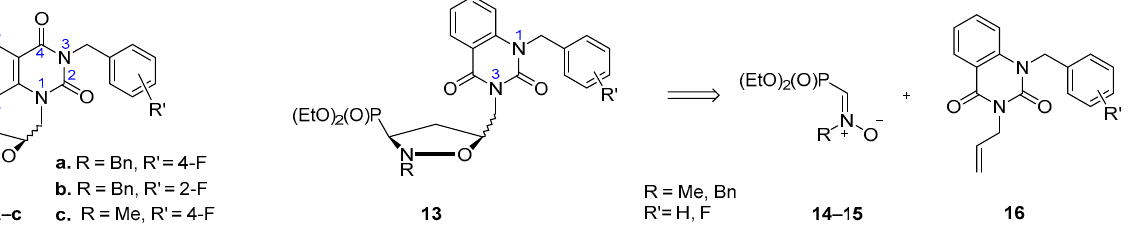
Figure 3. Examples of natural nucleosides (uridine, 2 ′ -deoxythymidine) and N3-substituted pyrimidine nucleotide analogues 10-11 .